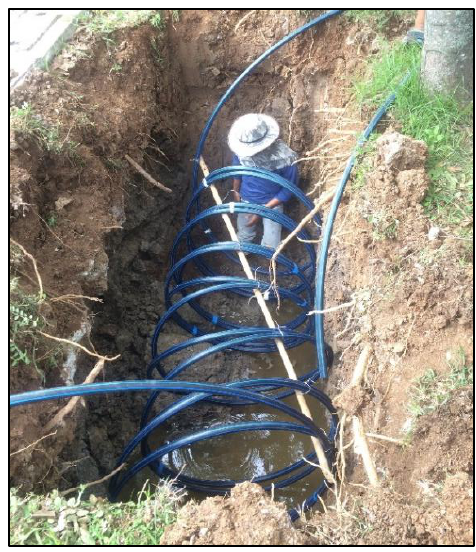
Figure 5. Installation of high-density polyethylene (HDPE) slinky pipes (Group 1). Energies 2019 , 12 , x FOR PEER REVIEW